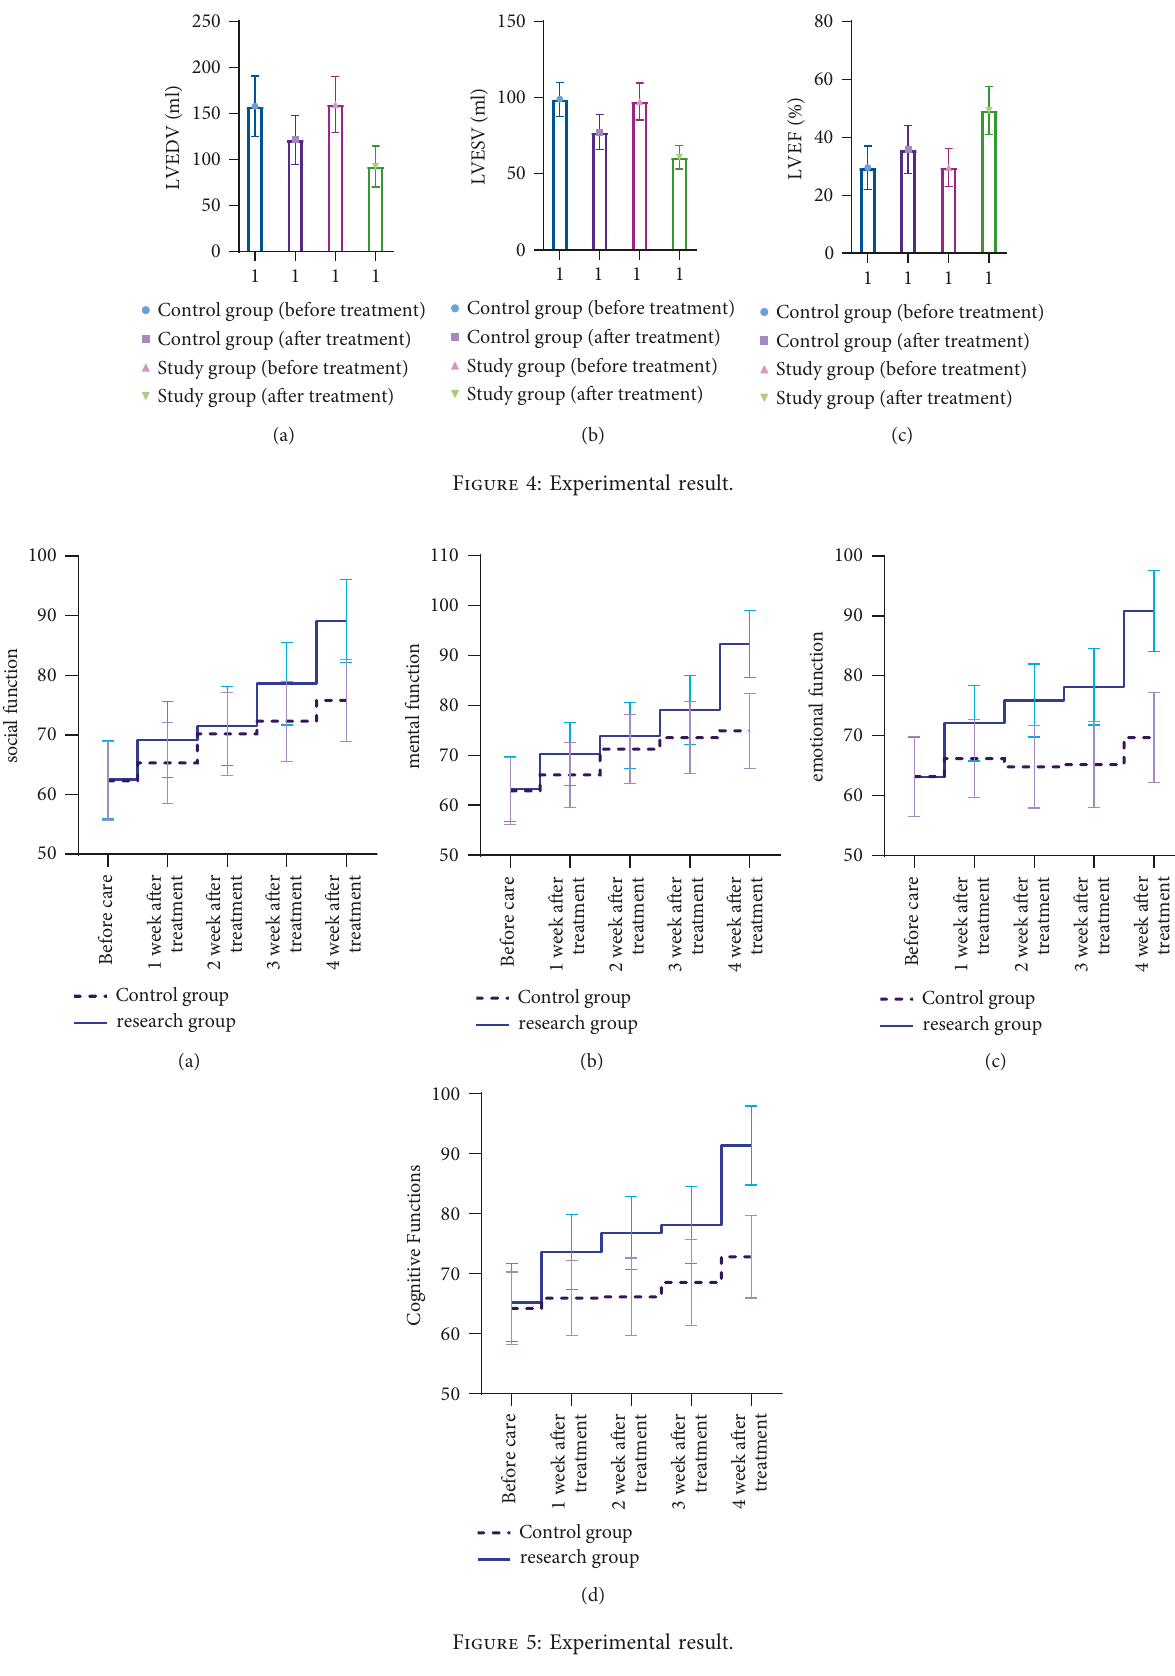
Figure 5: Experimental